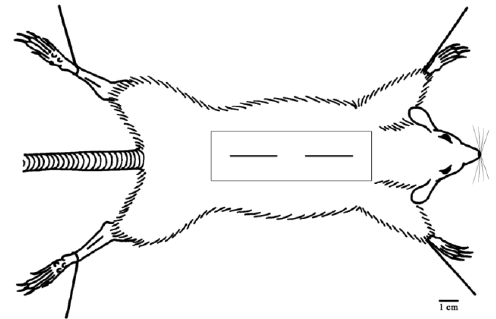
Figure 3. Illustration of the longitudinal incisional wounds that were made on the dorsal side of each